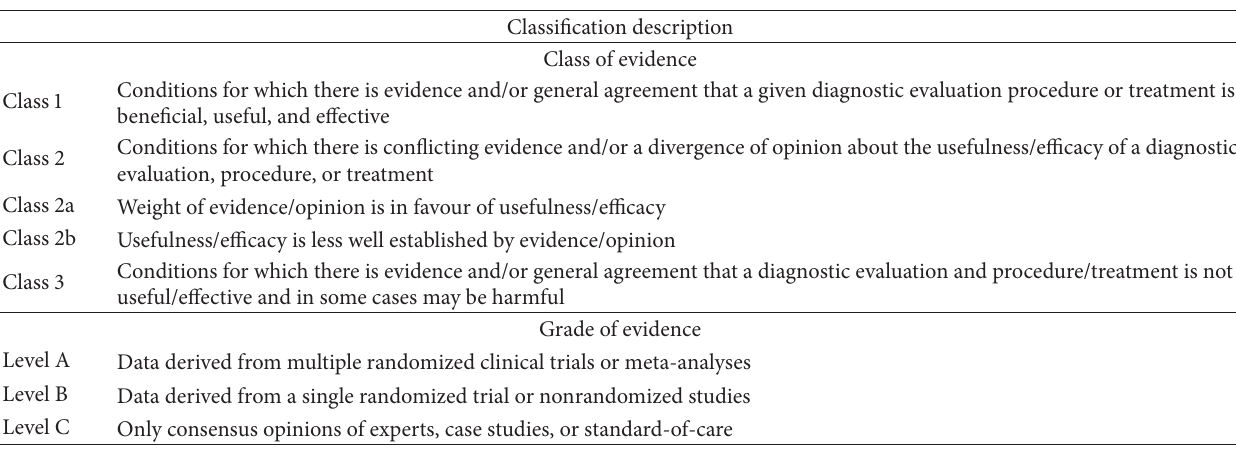
Table 1: Grading system for